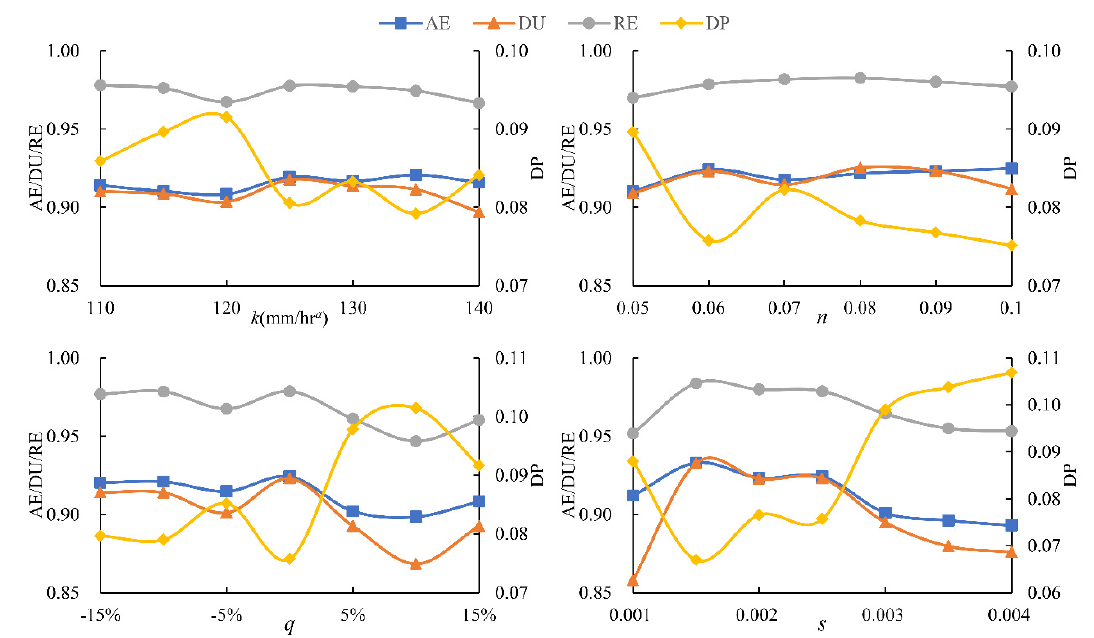
Figure 4. Sensitivity analysis of infiltration parameter k , roughness coefficient n , inflow rate q , and slope s .